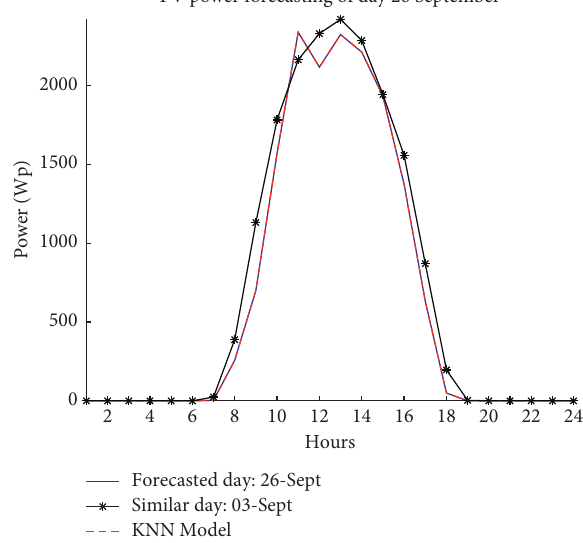
Figure 16: Similarity algorithm combined with KNN for forecasting the PV power of 26